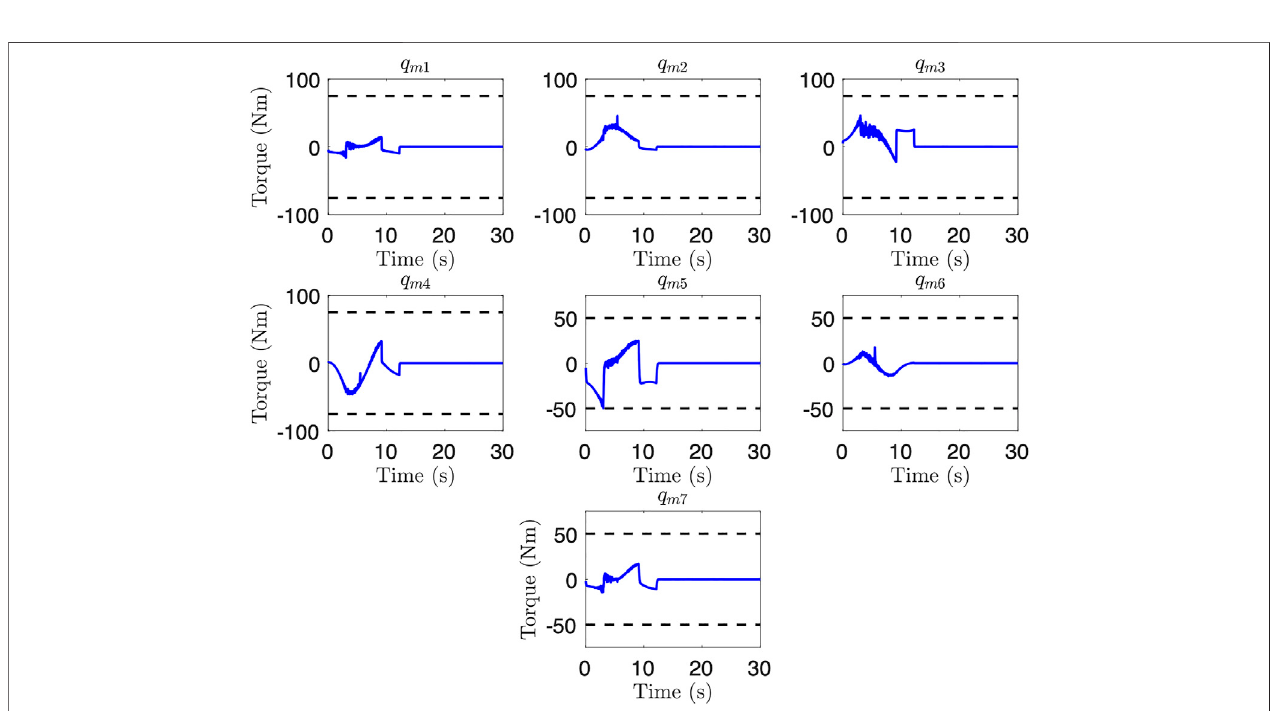
FIGURE 7 | Simulated motor torques for the uncontrolled fl oating base trajectory after optimization. Note that joint 5 reaches the lower torque limit.